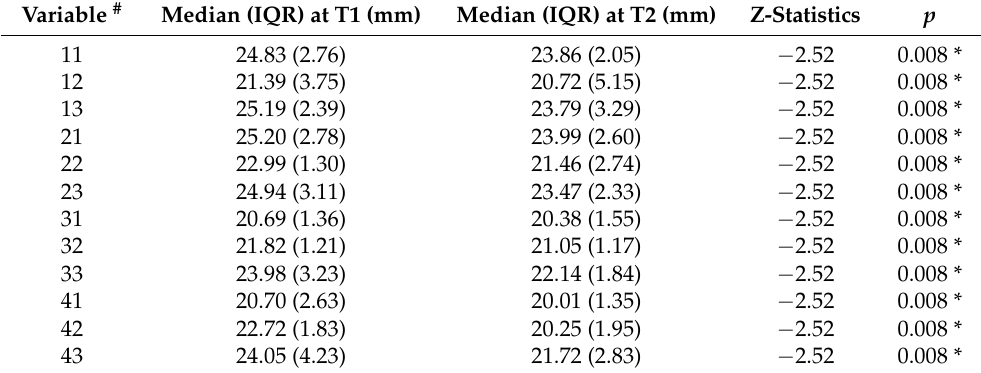
Table 3. Tooth length (root length and crown length) changes in SLNL group.